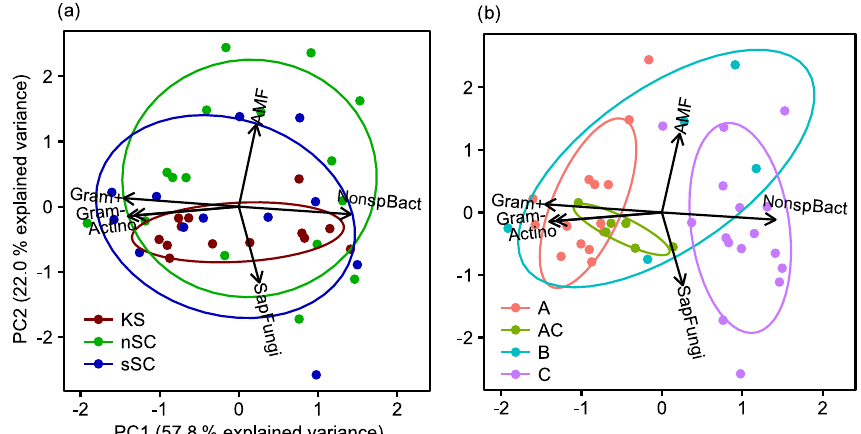
Figure 6. Biplots derived from a principal component analysis of functional microbial groups as identified from PLFA analysis. Colors and 68% confidence regions are grouped by (a) soil type and (b) horizon. Abbreviations: KS is Kastanozem, nSC is non-sodic Solonchak, sSC is Sodic Solonchak, Gram + is gram-positive bacteria, Gram– is gram-negative bacteria, Actino is actinomycetes, SapFungi is saprotrophic fungi, NonspBact is nonspecific bacteria, AMF is arbuscular mycorrhizal